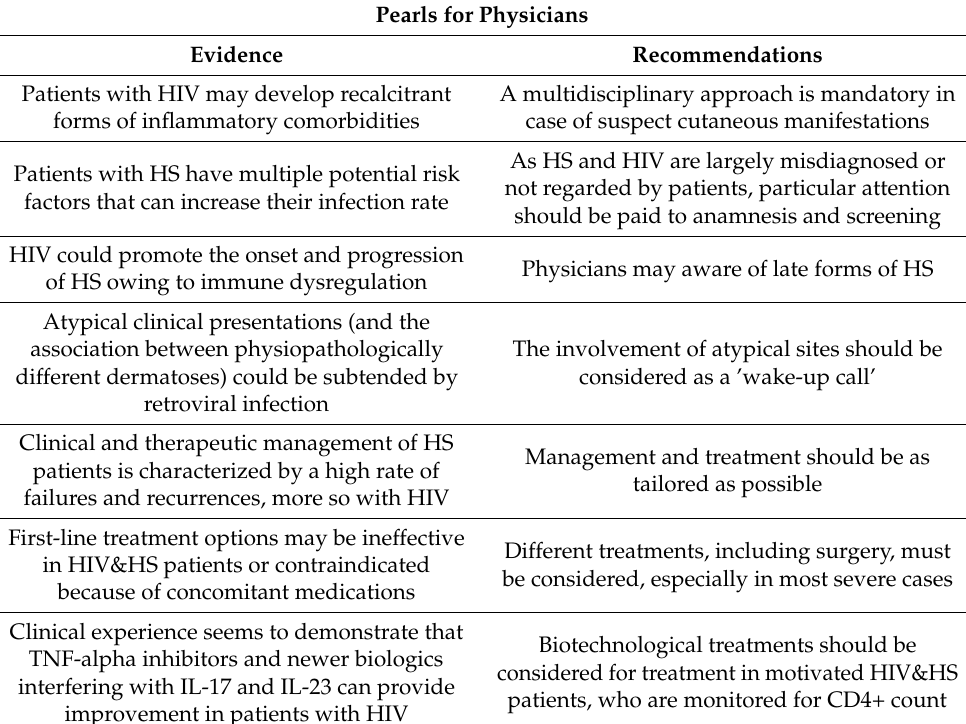
Table 2. Pearls for physicians: evidence and recommendations. Pearls for